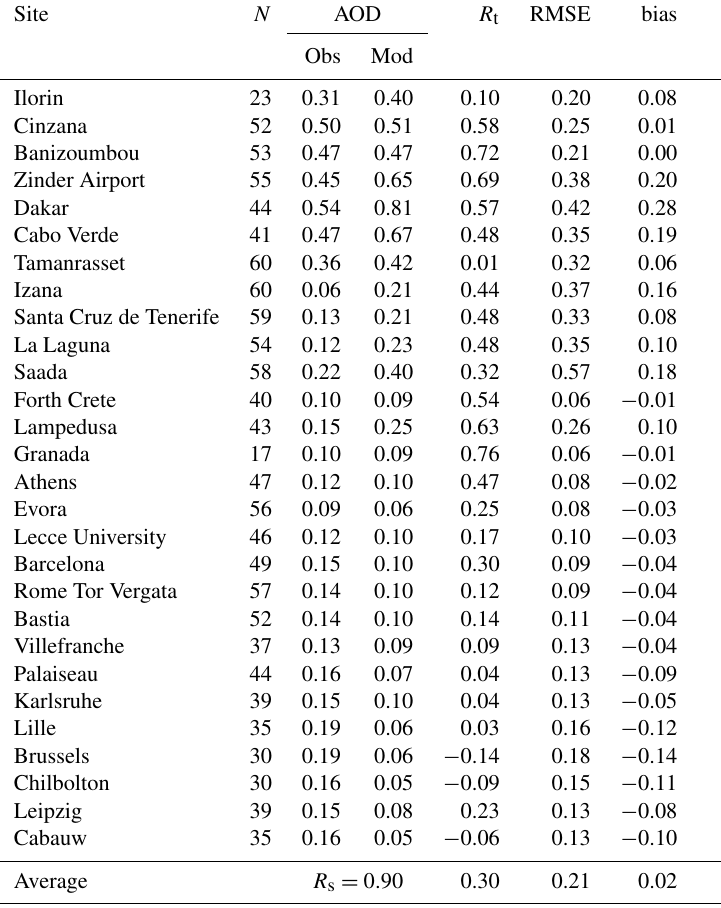
Table 5. Scores for the comparisons between observations (AERONET) and model (CHIMERE) for the aerosol optical depth (AOD). Results are presented with N the number of daily mean available measurements for the period from 10 June to 30 July 2013, the temporal correlation ( R t ), the root mean square error (RMSE) and the bias (model minus observations). The last line “average” represents the spatial correlation R s between the mean observed and modeled values, and the mean averaged values of temporal correlation, RMSE and bias. Stations are sorted in increasing latitude, from south to